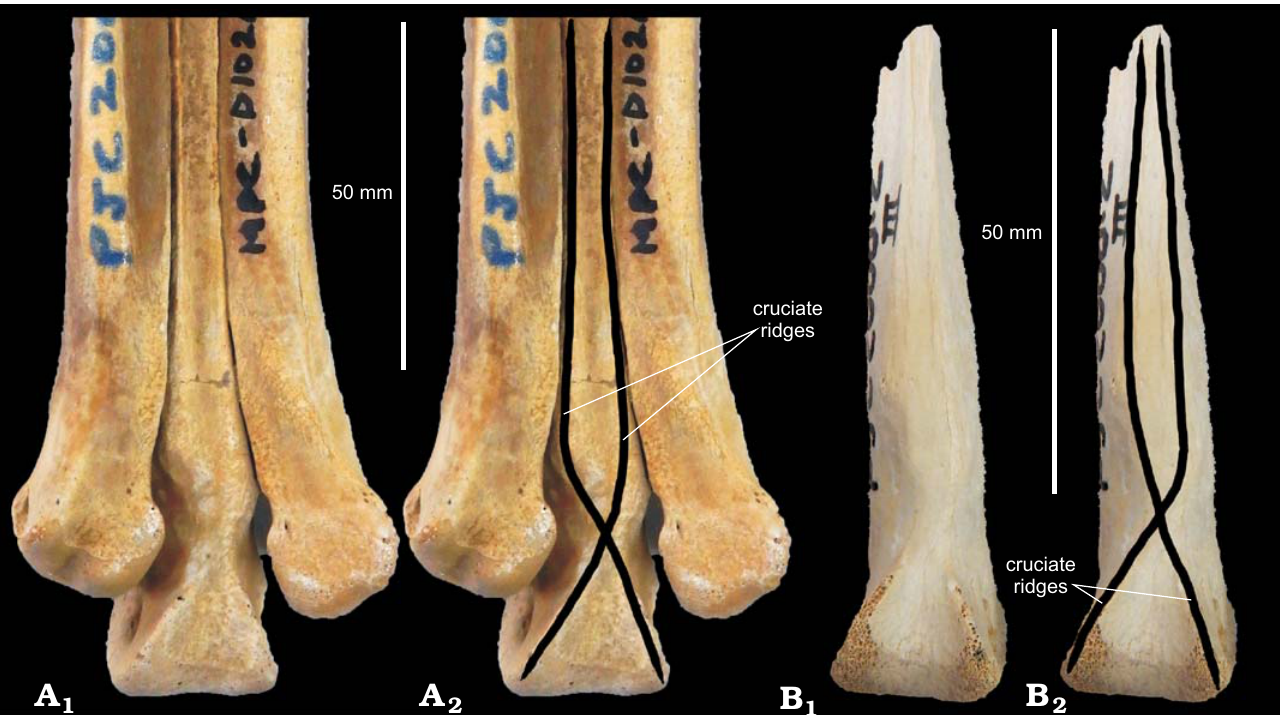
BB AA 2 1 2 1 Fig. 10. Crested theropod dinosaur Elmisaurus rarus Osmólska, 1981 from Nemegt Formation (Upper Cretaceous), Western Sayr of Nemegt locality, Mongolia; metatarsals in posterior view ( A , MPC-D 102/006; B , MPC-D 102/007), demonstrating the cruciate ridges of metatarsal III highlighted in A 2 , B 2 .